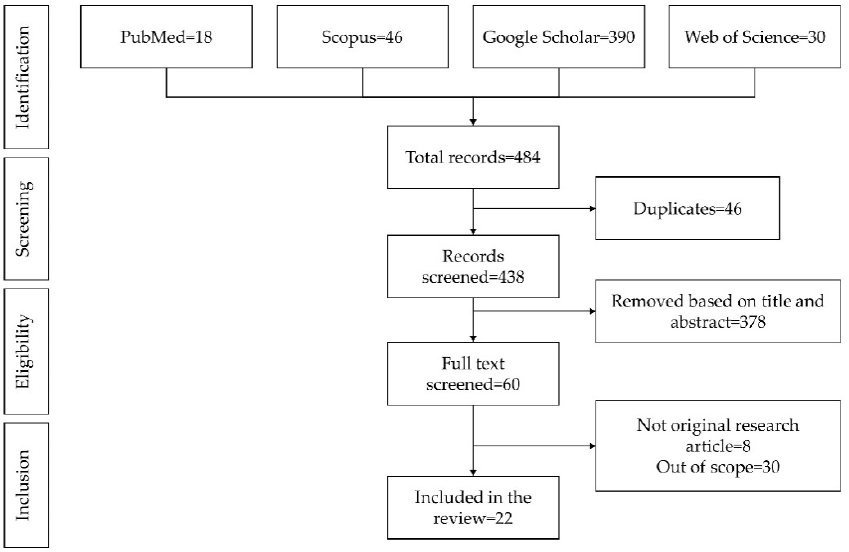
Figure 1. PRISMA flow chart for the literature search.